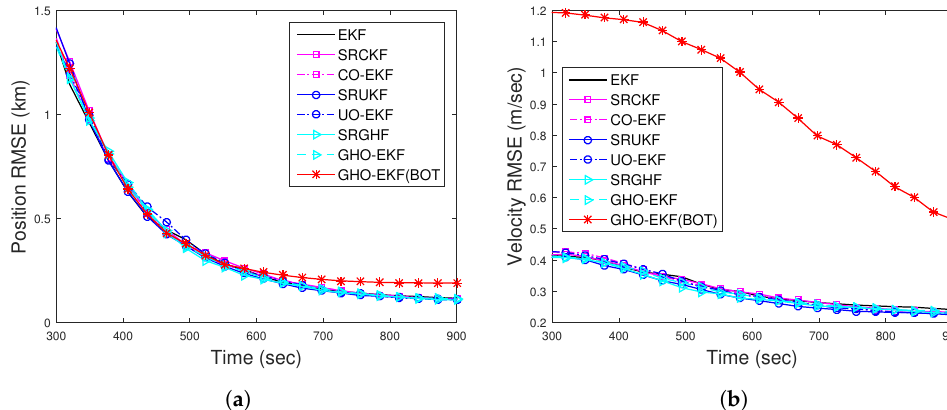
Figure 8. RMSEs of the ( a ) position; ( b ) velocity of the DBT for Scenario I.